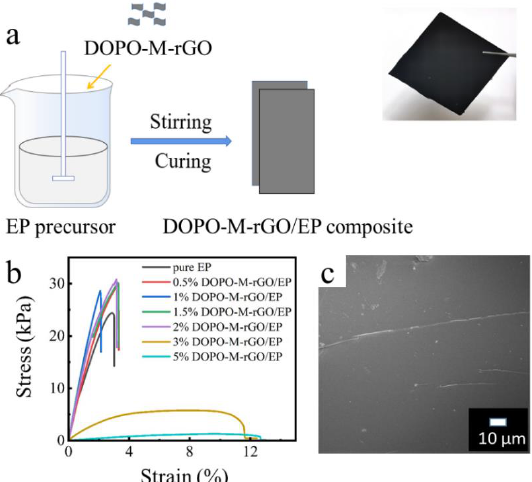
Figure 3. ( a ) Schematic representation for the preparation of DOPO-M-rGO/EP composite and the digital photographs of 1.5% DOPO-M-rGO/EP; ( b ) stress – stain curves of pure EP and the DOPO-M-rGO/EP composites with different DOPO-M-rGO contents; ( c ) SEM images of 1.5% DOPO-M-rGO/EP composite.